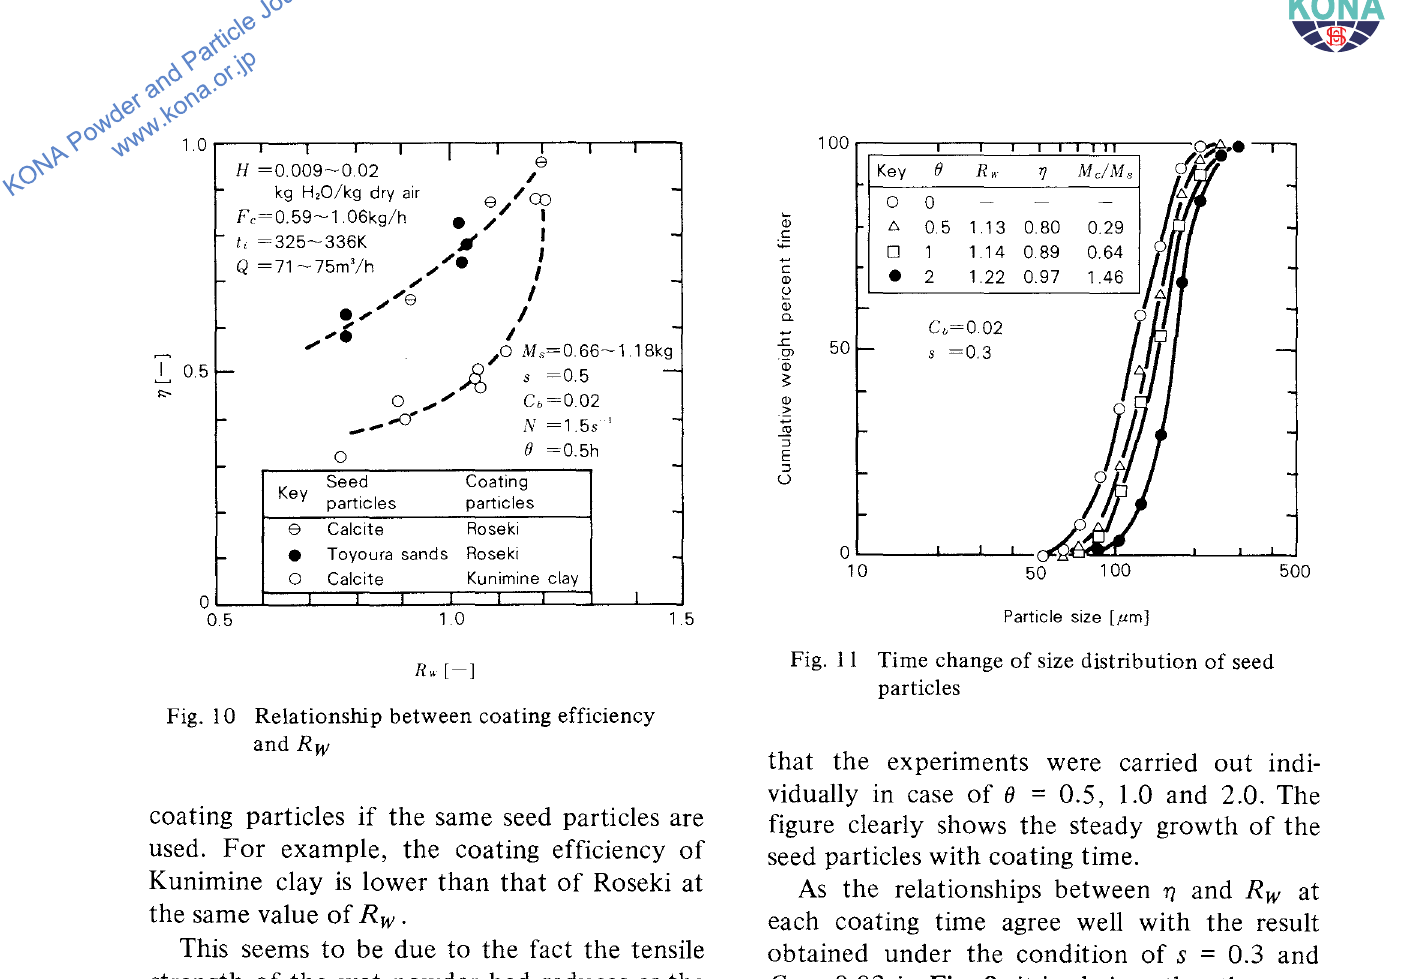
1.5 Fig. II Time change of size distribution of seed